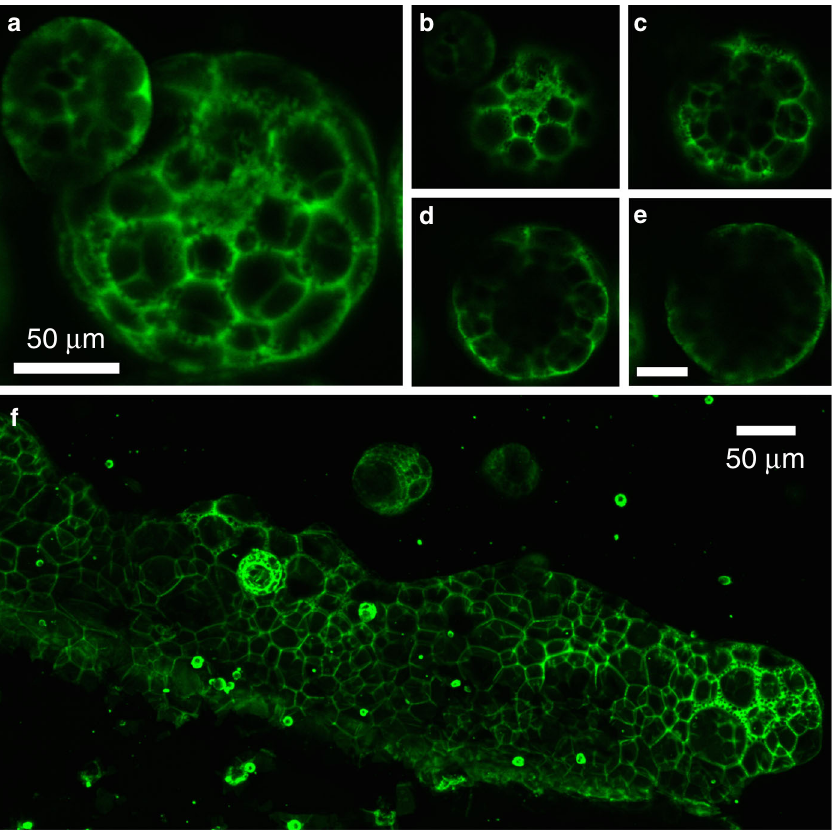
Fig. 3 Confocal imaging of foam structures. Confocal microscope z -projection images of a quantum dot foam droplet ( z depth = 23.13 μ m) with four representative slices ( b – e ) at z intervals of 0.665 μ m; and f a large foam structure ( z depth = 91.90 μ m). Scale bars for b – e are 50 µ